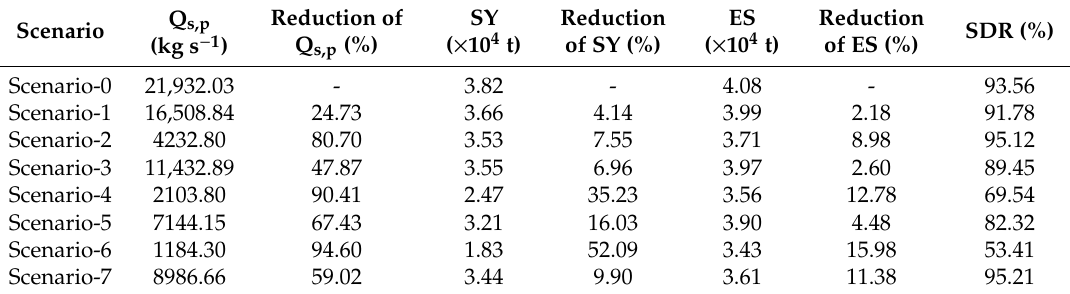
Table 6. Sediment transport characteristics under di ff erent